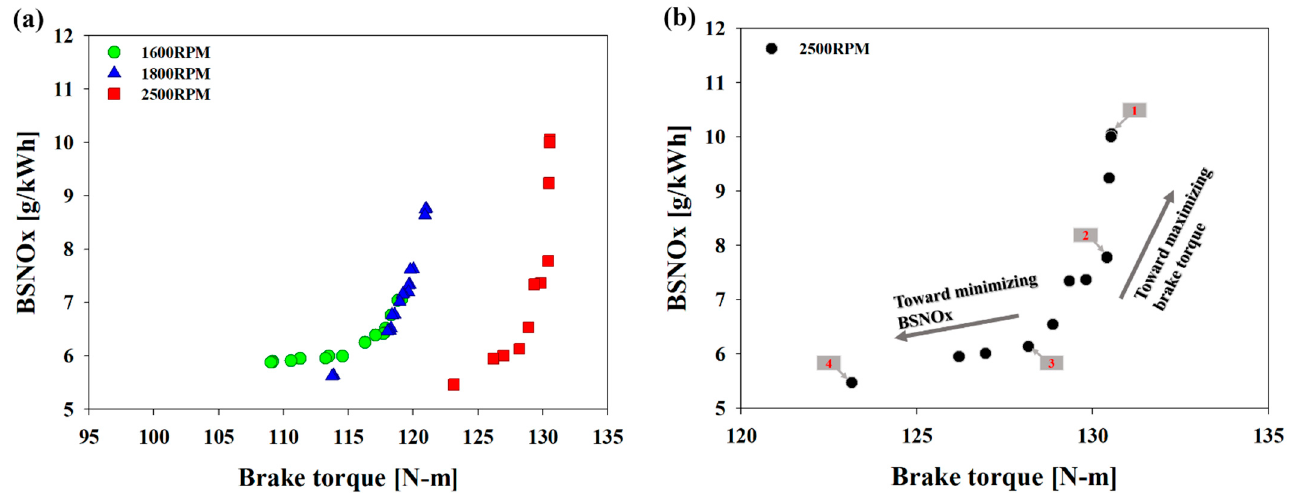
Figure 12. ( a ) Pareto optimum solution according to the Brake torque and BSNOx. ( b ) Design points of the pareto optimum solution.